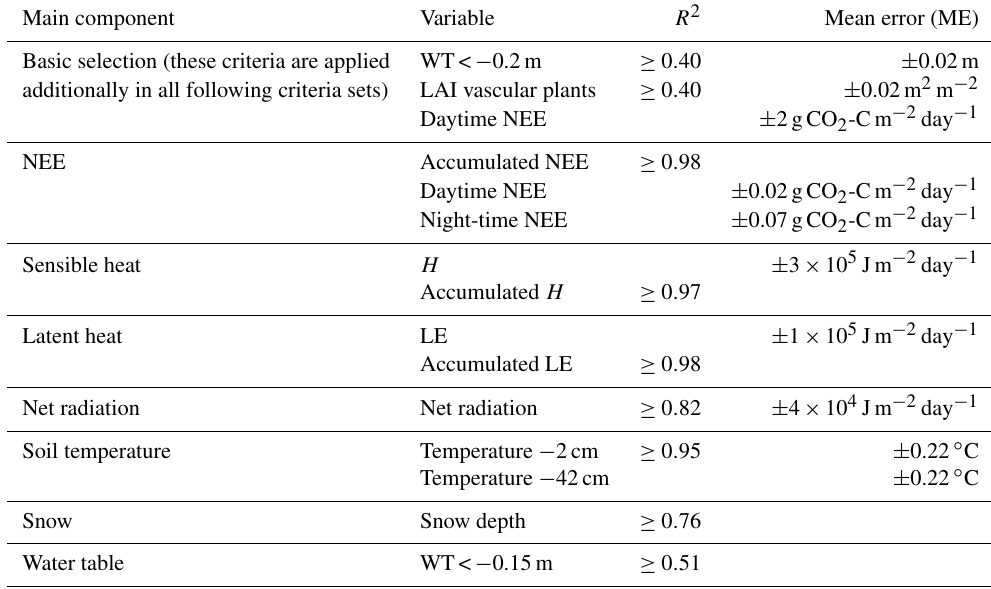
Snow Snow depth Water table WT< − 0.15m ≥ 0 .